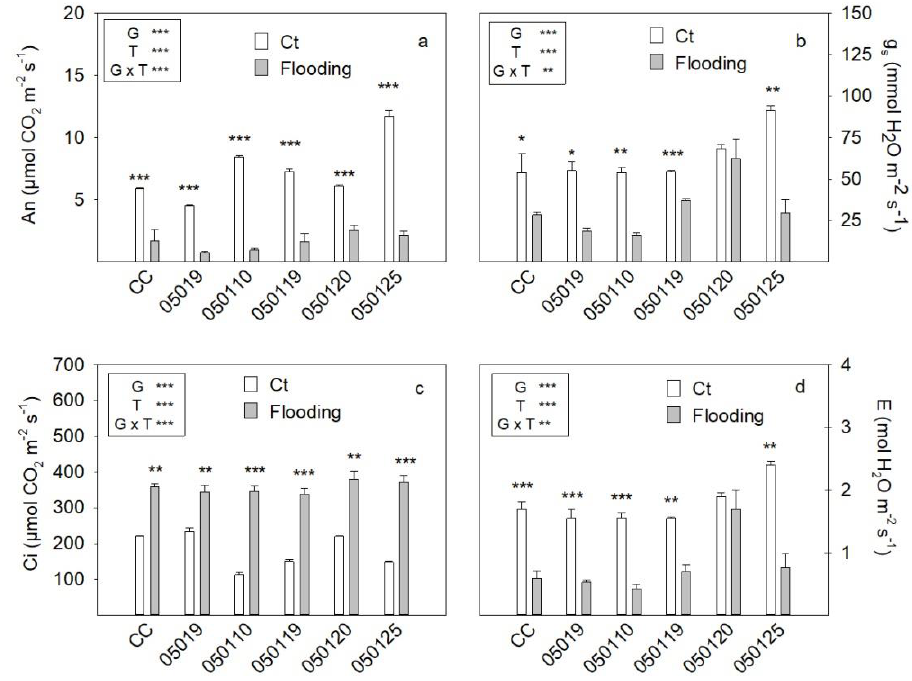
Figure 3. ( a ) Net photosynthesis (An), ( b ) stomatal conductance (g s ), ( c ) internal CO 2 concentration (Ci), and ( d ) evap- otranspiration (E) measured in young and well-developed (fully expanded) leaves from five citrus hybrids grown for 35 days in the non-stressed (Ct) or flooding treatment. Values are the means of six independent seedlings ( n = 6). In each hybrid, comparisons among treatments were made by Fisher’s least significance difference (LSD) test. * p < 0.05, ** p < 0.01, *** p < 0.001. CC: Carrizo citrange; G: genotype, T: